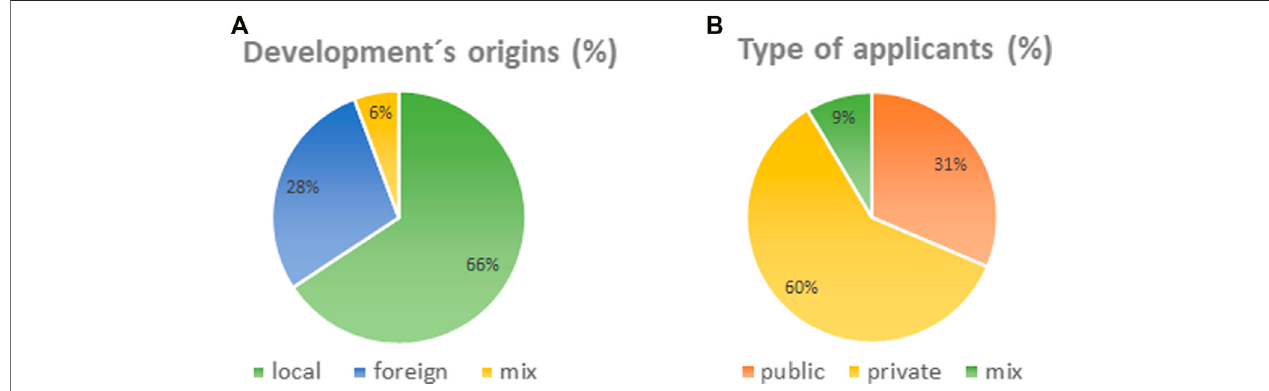
FIGURE2|(A) OriginofPCI submitted totheCoordinationofInnovation and Biotechnology ofthe National Directorate ofBioeconomy. (B) Type ofapplicants that submitted